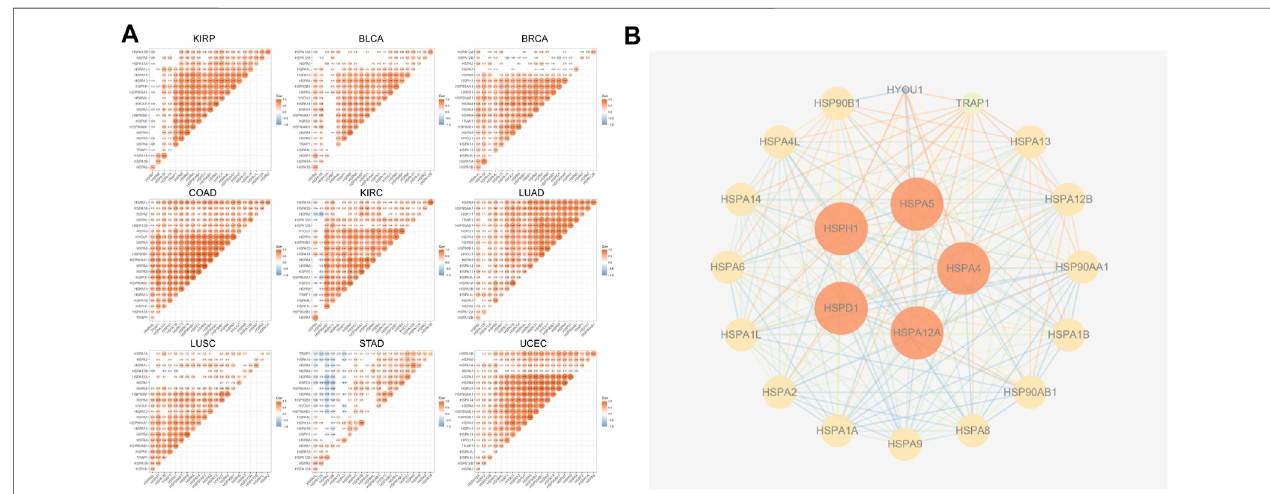
FIGURE 3 | The correlation analysis and protein-protein interactions among HSPs. (A) The correlations among HSP expressions. Red color represents positive correlation and blue color represents negative color ( p < 0.05). CCLE, Cancer Cell Line Encyclopedia. HSP, heat shock protein. (B) Protein-protein interaction network among HSP family. The higher the degree score, the larger the